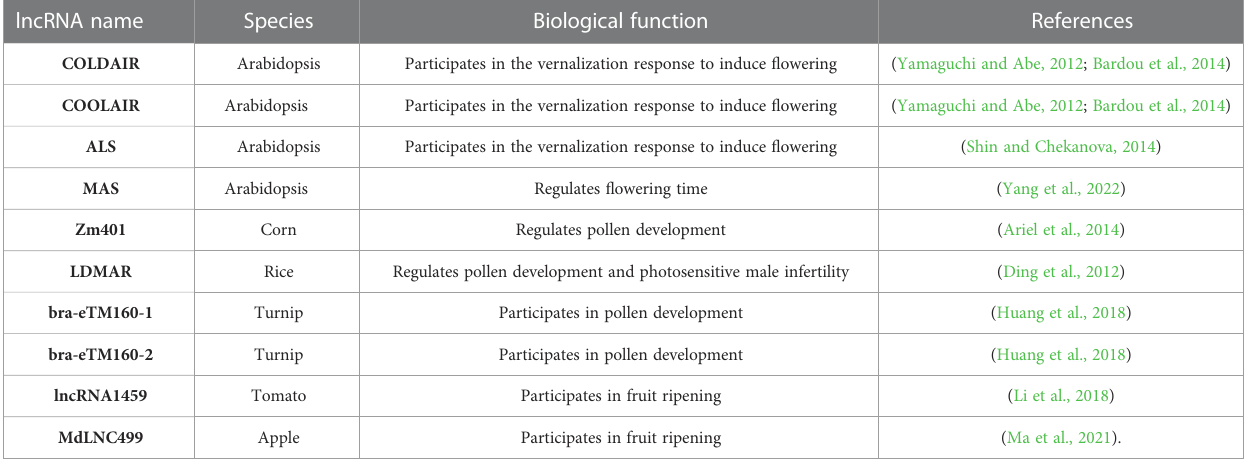
TABLE 2 lncRNAs participating in